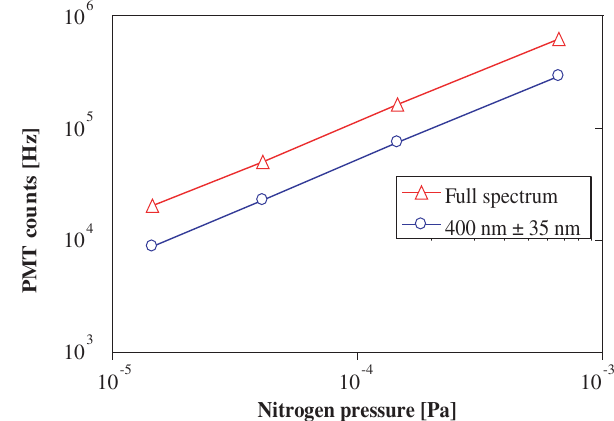
FIG. 16. (Color) Emitted photons vs nitrogen injected pressure. Triangles show the full spectrum acquisition while circles rep- resent the data obtained with a chromatic filter at 400 nm. Figure 16 was already published in [8].